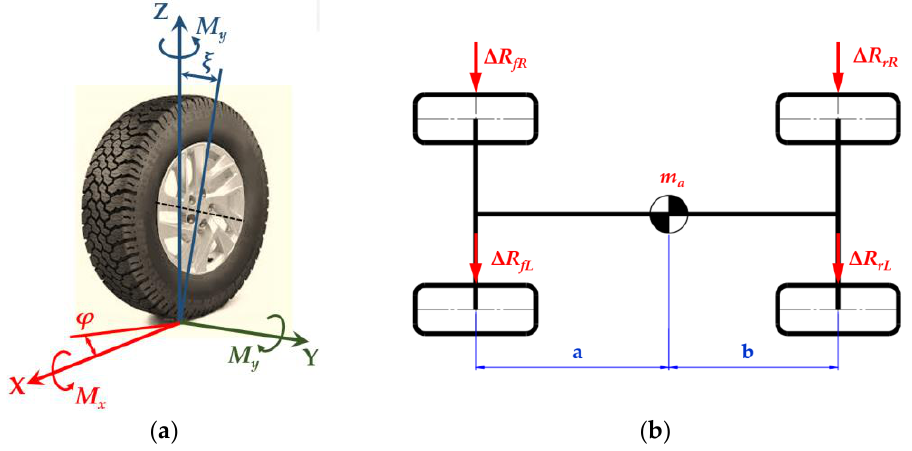
Figure 23. Wheel coordinate system of the 3D model ( a ); lateral forces acting on the wheels ( b ).